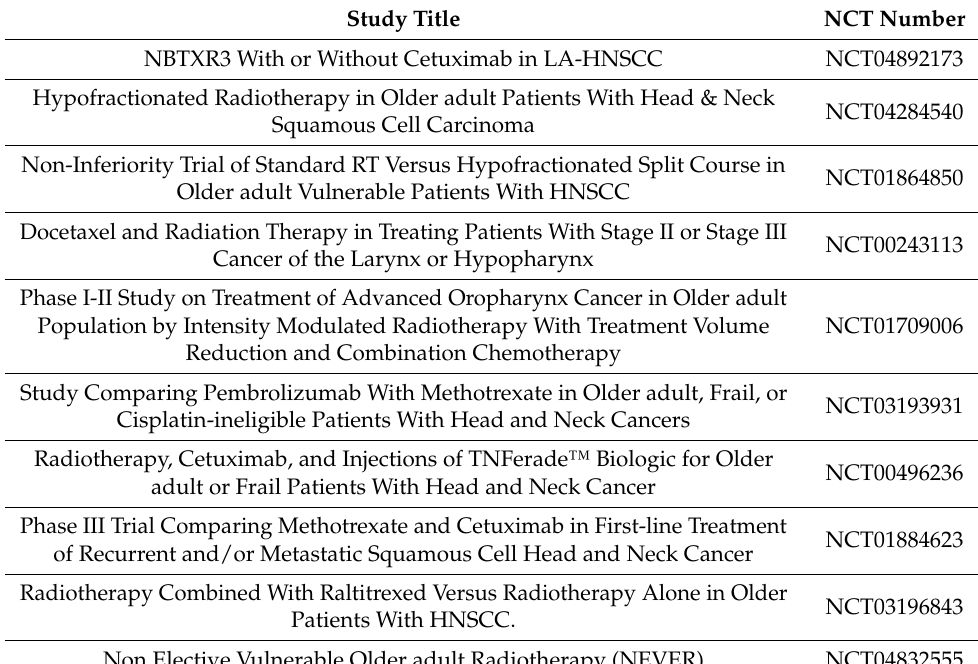
Table 1. Ongoing Clinical Trials for Older adult Patients with Locally Advanced Head and Neck